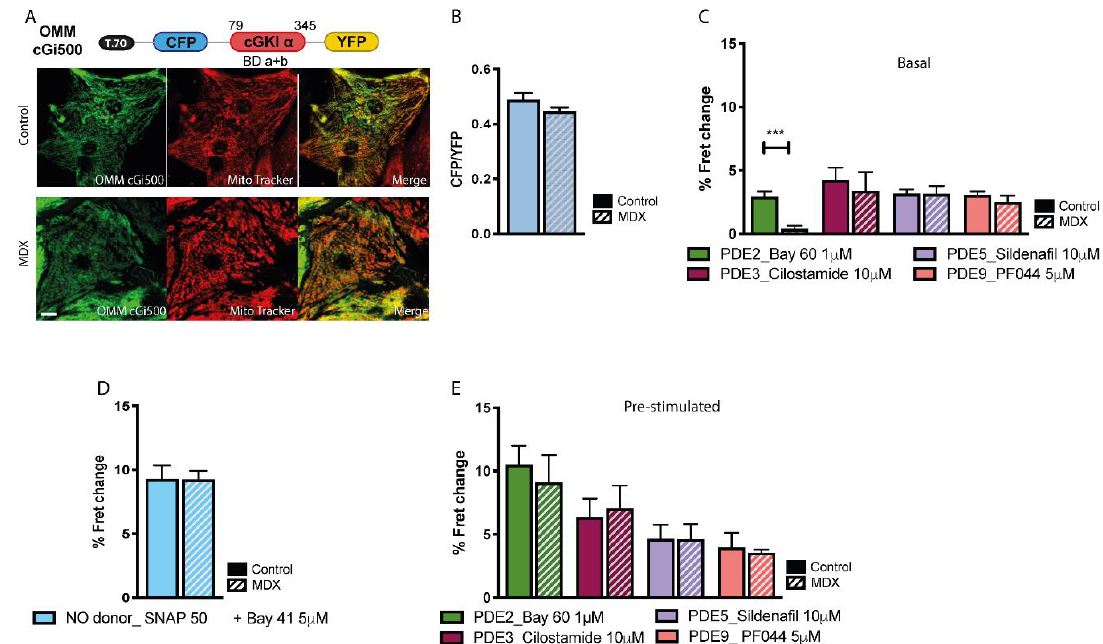
Figure 3. Comparison of cGMP signals at the outer mitochondrial membrane (OMM) of NVM from control and mdx mice. ( A ) Top: schematic representation of the OMM-targeted cGMP FRET reporter OMM-cGi500. T.70 indicates translocase outer mitochondria membrane protein TOM 70. Bottom: at the left, representative images of NVM from control and mdx mice expressing OMM-cGi500. Co-staining with the mitochondria specific dye mitotracker is shown in the central panel and the overlay is shown at the right. ( B ) Mean relative values for CFP to YFP fluorescence intensity ratio recorded in unstimulated NVM from control and mdx mice expressing OMM-cGi500. n = 4. ( C ) Mean FRET change recorded in NVM expressing OMM-cGi500 on application of family-selective cGMP-PDE inhibitors as indicated n = 4. ( D ) Mean FRET change recorded in NVM from control or mdx mice expressing OMM-cGi500 on application of the NO donor SNAP in combination with the cGC stimulator Bay-41. n = 4. ( E ) Mean FRET change recorded in NVM expressing OMM-cGi500 on application of family-selective cGMP-PDE inhibitors, as indicated, in cells pre-treated as in ( D ) n = 4. For all data, mean ± SEM are shown. *** = p < 0.001. Size bar: 10 µ